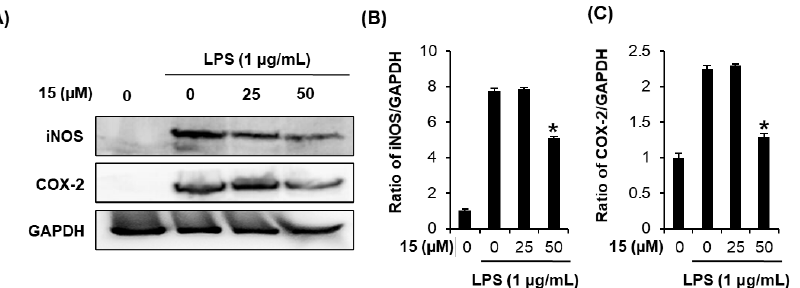
Figure 5. Effects of benzyl salicylate ( 15 ) on the expression of inducible nitric oxide synthase